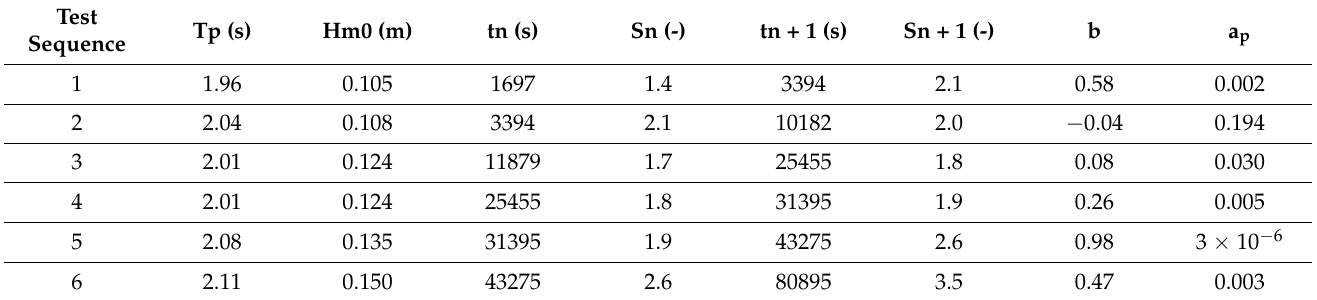
Table 5. Average sea-wave characteristics at the toe of the structure for each test sequence, time at the beginning and at the end of the test sequence, corresponding to the measured dimensionless parameters and estimated coefficients a p and b for Melby’s